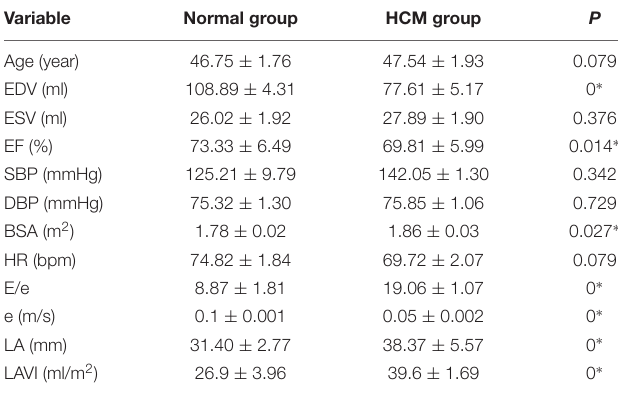
TABLE 1 | Comparison of general